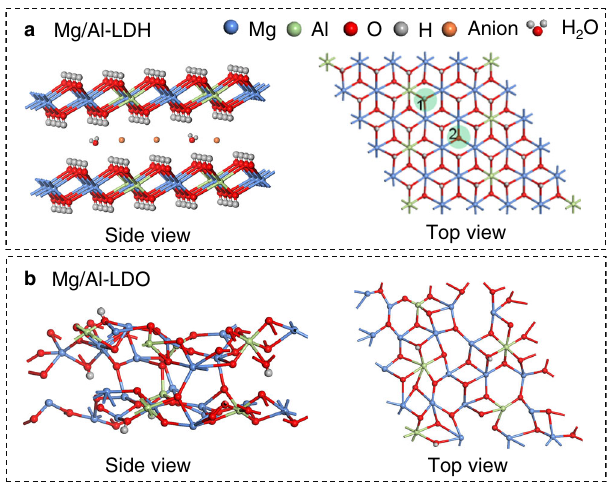
Fig. 1 | Structure of Mg/Al-LDH and Mg/Al-LDO. Schematic structure of Mg/Al- LDH( a )andMg/Al-LDO( b )inthesideandtopviews.Theshadedgreencirclesshow the local environment of Mg 2 AlOH (1) and Mg 3 OH (2).